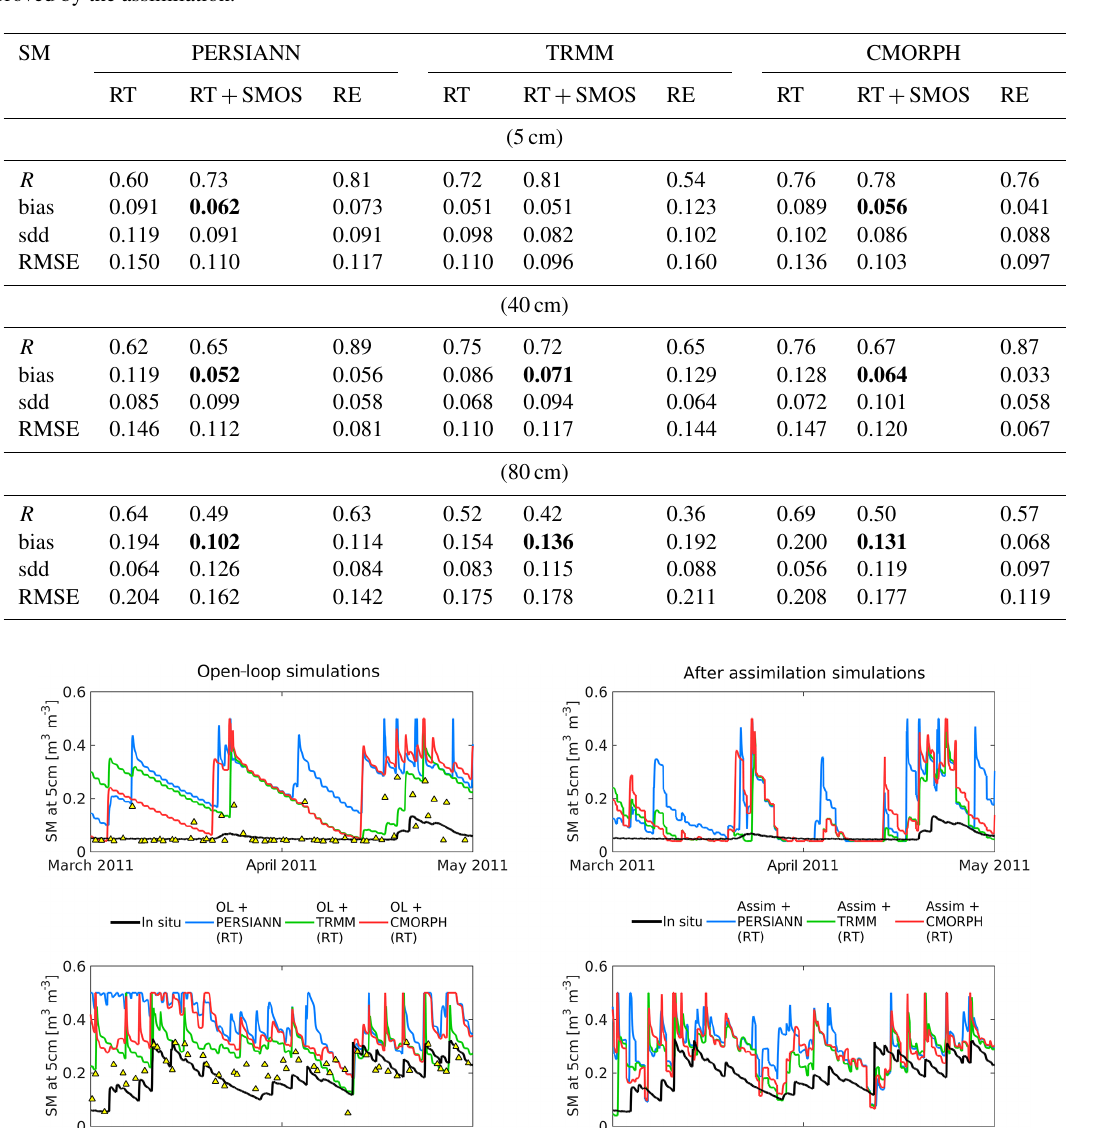
Table 2. Statistics of the simulated soil moisture at 3 depths (5, 40 and 80cm) compared to the in situ measurements at the Bira station for 2010–2012. Three cases are considered: open-loop simulations using real-time satellite precipitation (RT), assimilation of SMOS soil moisture with real-time precipitation (RT + SMOS) and open-loop simulation using reanalyzed precipitation (RE). Bias, standard deviation of the difference (sdd) and root mean square error (RMSE) are in m 3 m − 3 , the correlation ( R ) is dimensionless. Bold font is used when the bias is improved by the assimilation.